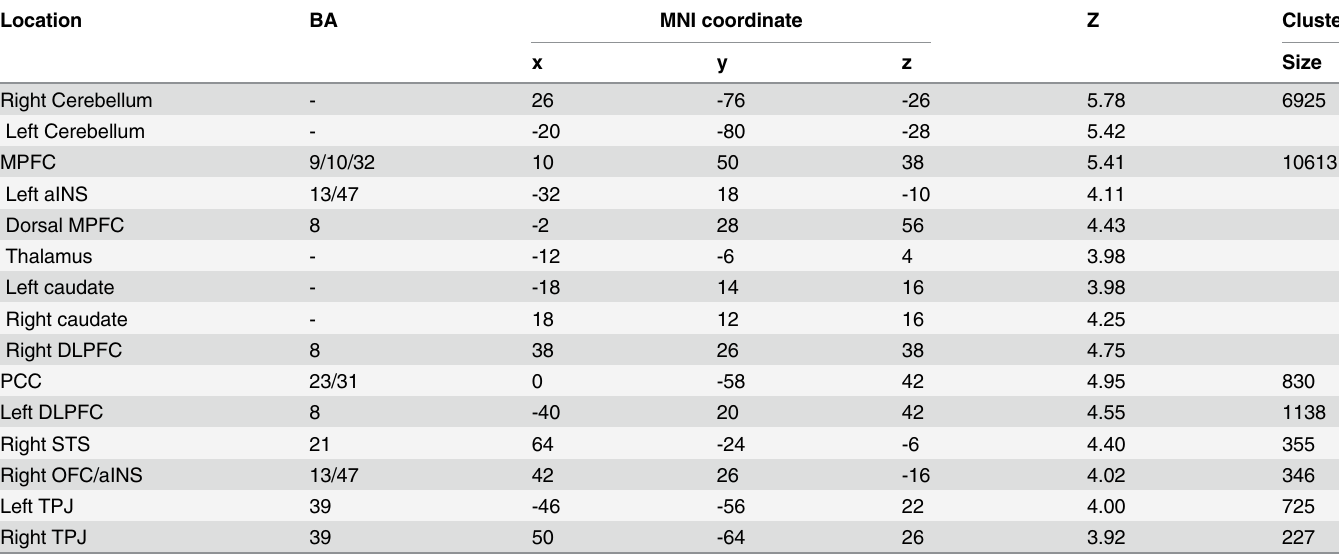
Table 1. Brain areas activated by the human vs. computer contrast.